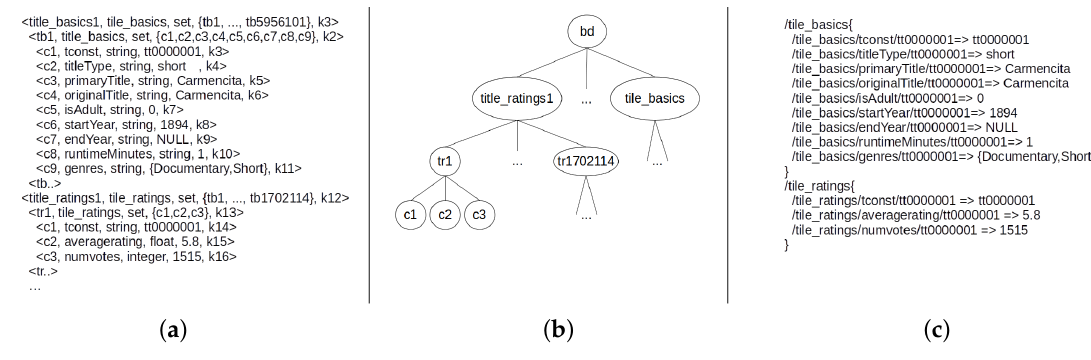
Figure 9. Table Movie represented in a VOEM data